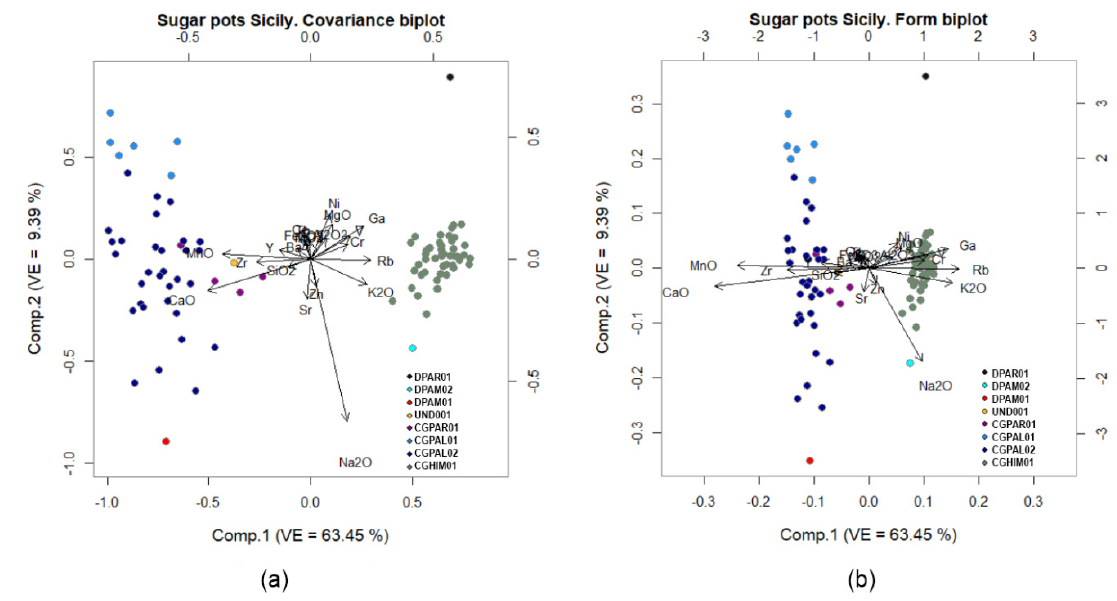
Figure 7. Covariance ( a ) and form ( b ) biplots of the principal component analysis using the singular value decomposition of the double-centred clr-transformed sub-composition Na 2 O, MgO, Al 2 O 3 , SiO 2 , K 2 O, CaO, TiO 2 , V, Cr, MnO, Fe 2 O 3 , Ni, Zn, Ga, Rb, Sr, Y, Zr, Nb, Ba, Ce, and Th. Table 3. Mean ( x(cid:3364) ), standard deviation (s), and total variation (tv) of the groups of more than two samples and values of the loners (as normalised values). Major and minor elements (expressed as oxides) in w %. Trace elements in µg/g.